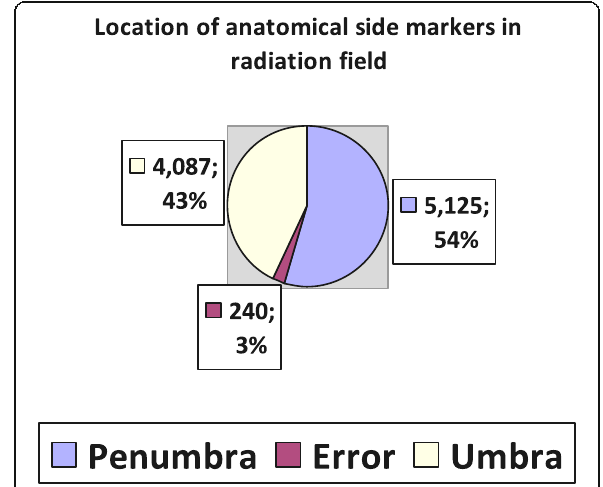
Fig. 6 Pie chart of anatomical marker locations within radiation